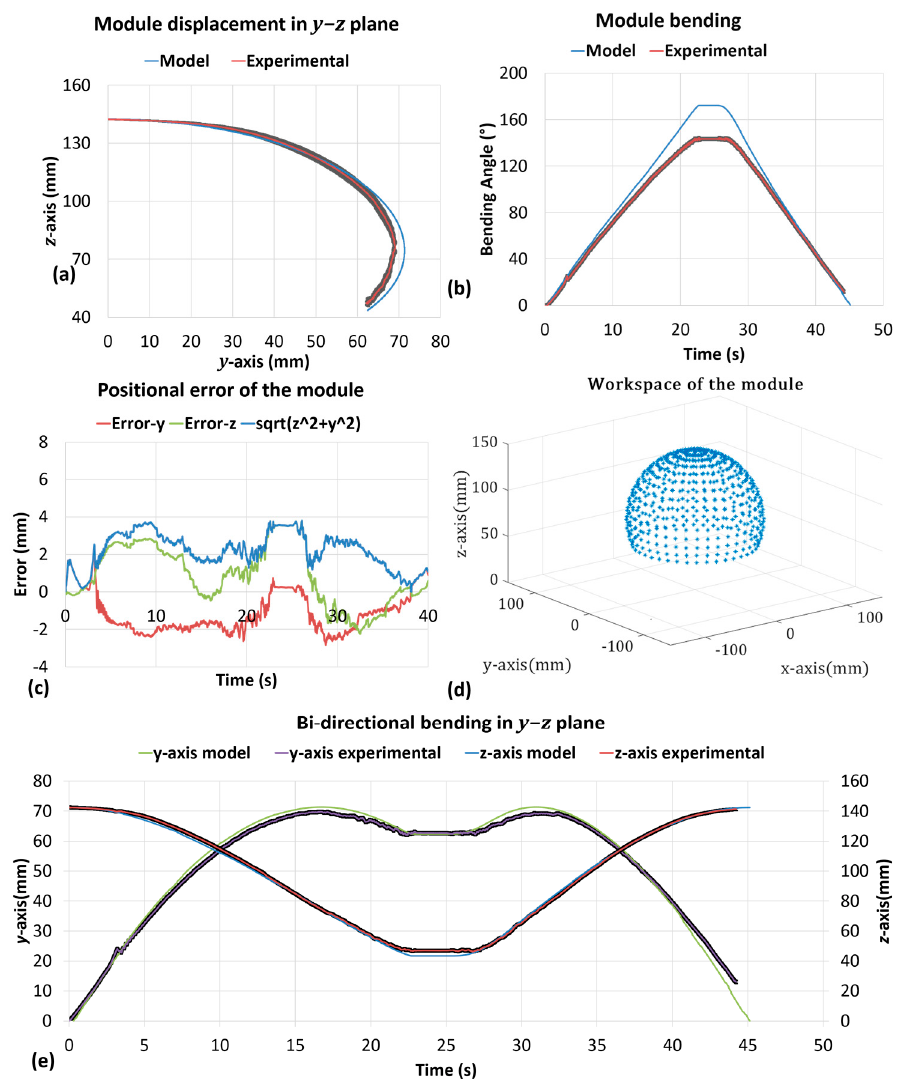
Figure 11. Kinematic model validation and characterization of the module. ( a ) Bending of the module in x – y plane; ( b ) model validation of the bending angle about x ‐ axis; ( c ) measured error in y – z plane between Aurora results and model; ( d ) whole workspace of the module in 3D space; and ( e ) bi ‐ directional bending of the module.